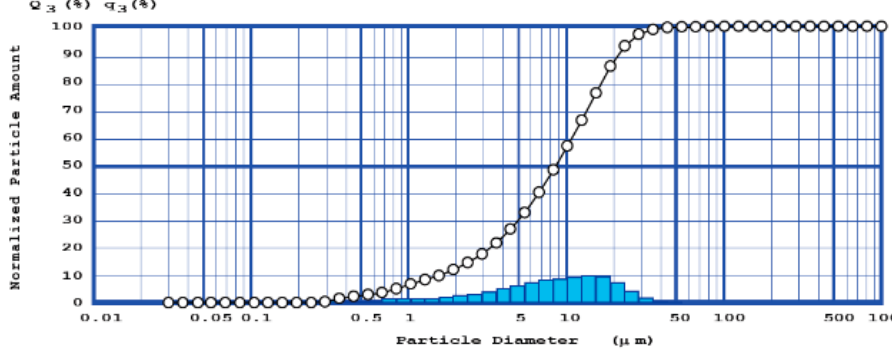
Figure 2. Particle size distribution of cement.